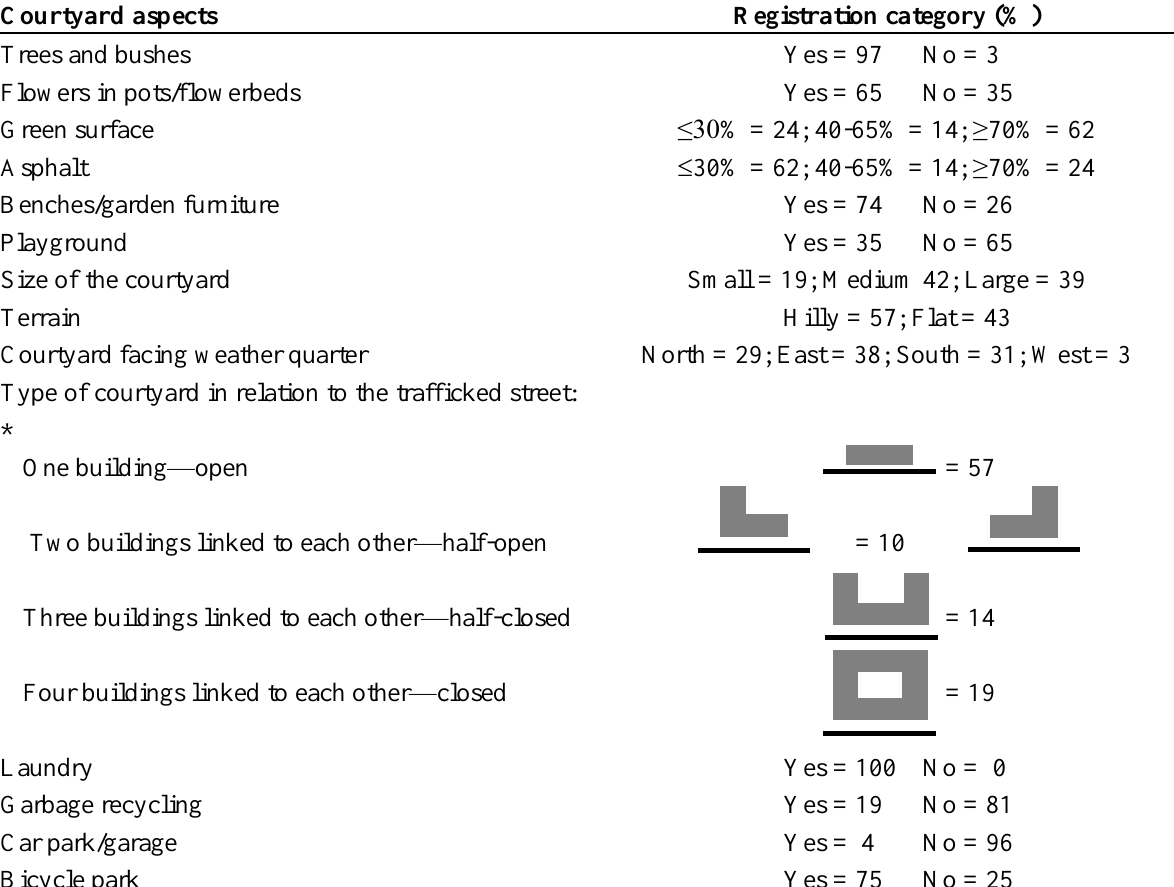
Table 1. Distribution in percent for registered physical environmental aspects of ―quiet‖ courtyards.